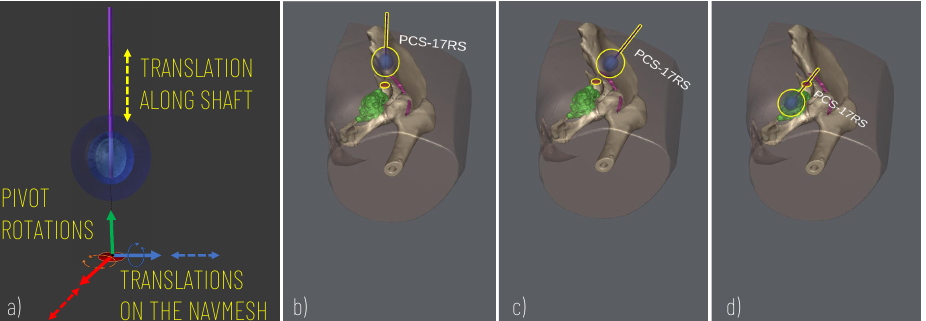
Figure 3. Simulation of the cryoprobe placement. ( a ) 5 DOF modelled for defining the best insertion point (2 DOF translations for displacement on the skin model), insertion axis (2 pivot rotations), and insertion depth (1 DOF translation). ( b – d ) Example of sequences of simulator scenes after pivot rotation ( c ) and translation ( d ) along the cryoprobe longitudinal